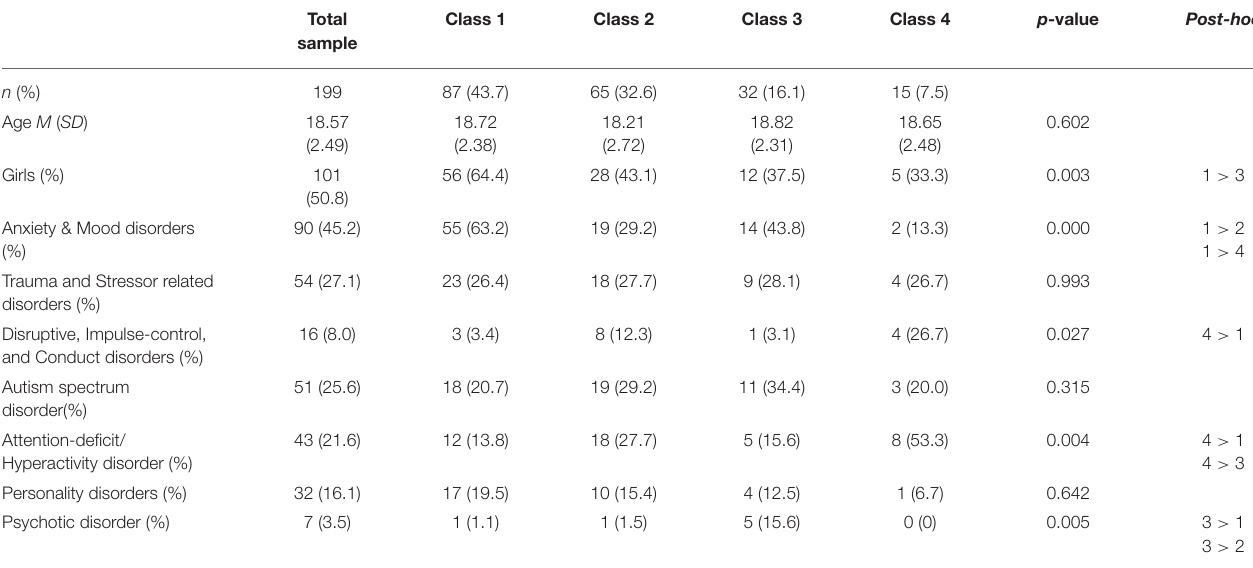
TABLE 4 | Mean age, sex, and clinical diagnoses of the overall sample and per class. Total Class 1 Class 2 Class 3 Class sample